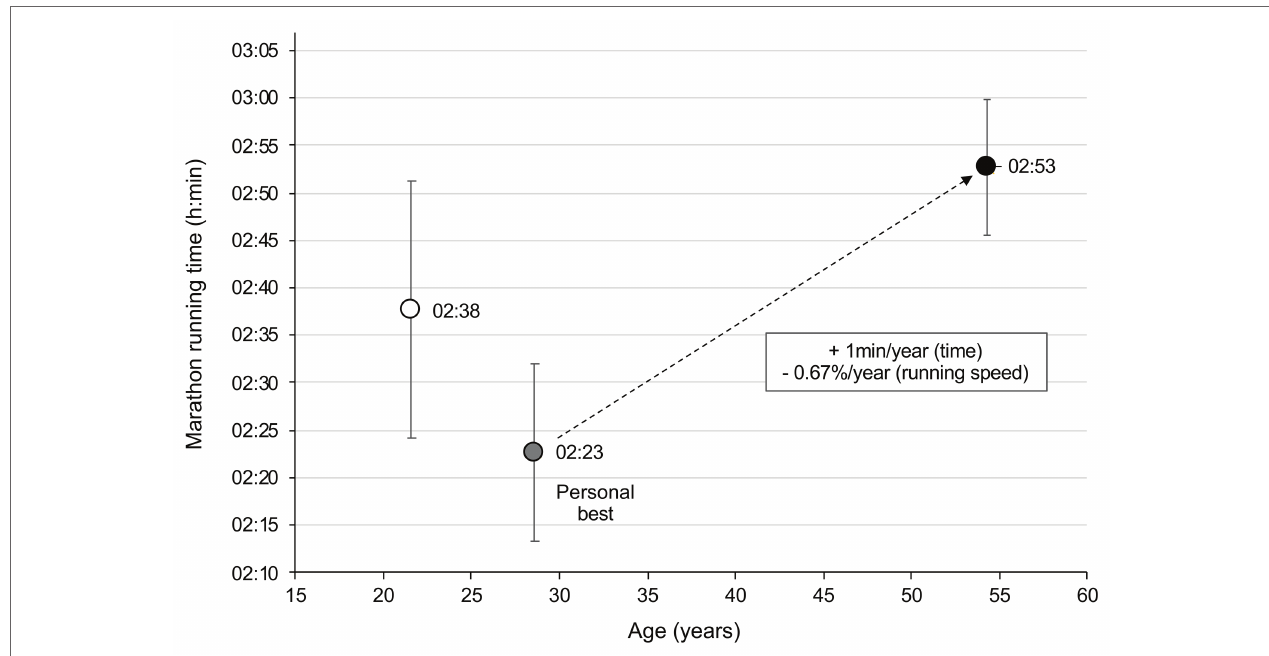
FIGURE 2 | Mean (+/ − 1 SD) changes in marathon running performance of the 5DS3 runners ( n = 40) plotted against increasing age between their first race and their last